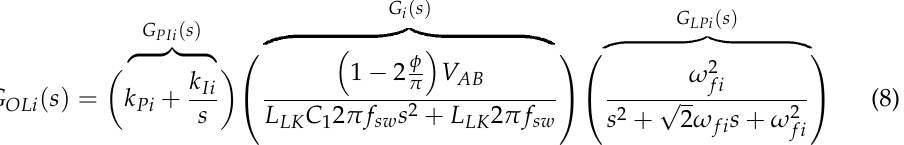
Assuming that the crossover frequency of the current loop is greater than the cross- over frequency of the voltage loop, the open-loop TF of the voltage loop is given in Equa- tion 8. Figure 14. Block scheme of the control loop used to achieve the control tuning of the DAB con- verter. The open-loop TF of the current-loop G OLi (s) has three terms, as shown in Equation (7). G PIi (s) is the TF of the current controller and G LPi is the TF of the low-pass filter. G i (s) is the TF from phase shift perturbation 𝜙(cid:3552) to the input current perturbation 𝚤̂ b , where V AB is the input voltage between the phase legs of the first full-bridge at a steady state, (cid:31) is the phase shift at a steady-state and L LK is the total leakage inductance of the transformer, L LK = L 1 + ( N 1 / N 2 ) 2 L 2 .